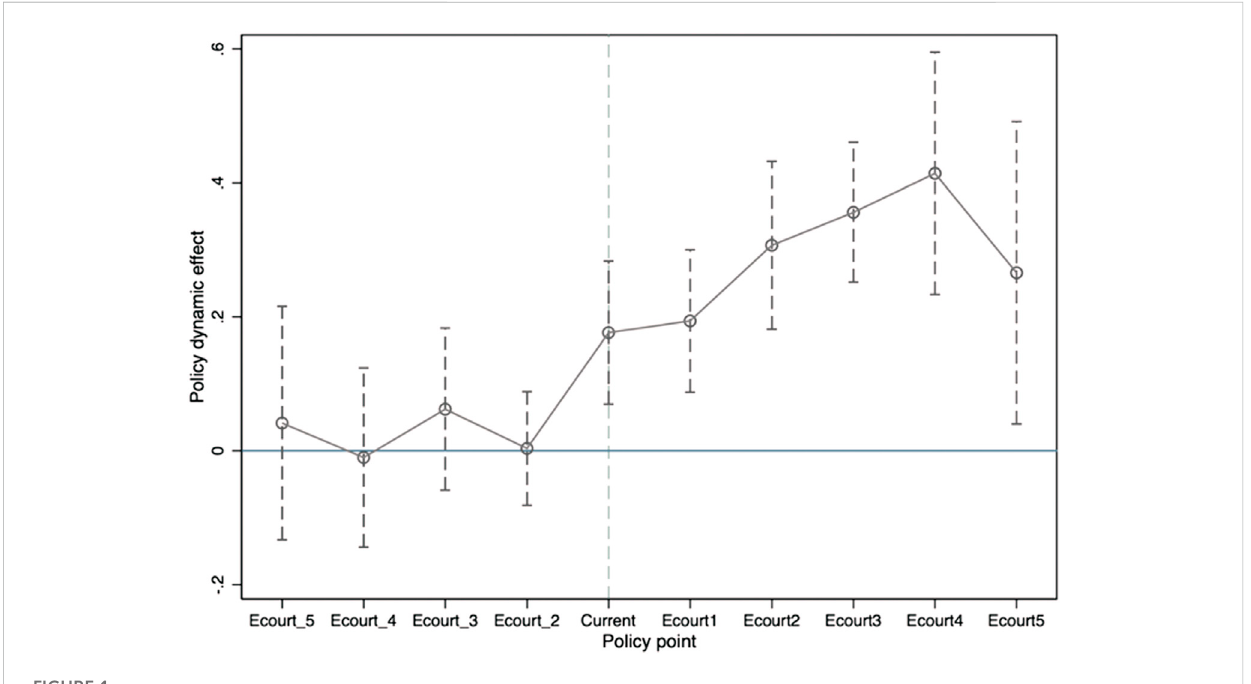
FIGURE 1 Parallel trend Test for TGpatent